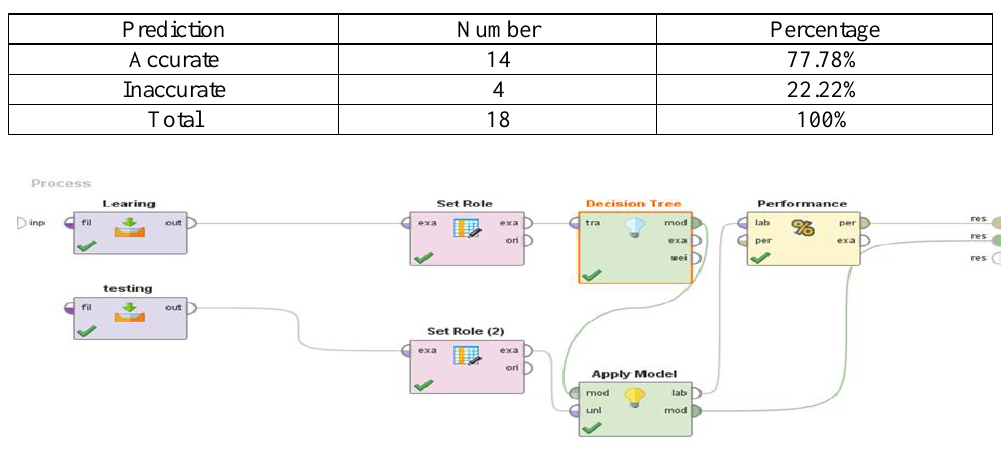
Table 3. Prediction accuracy of C4.5 Decision Tree